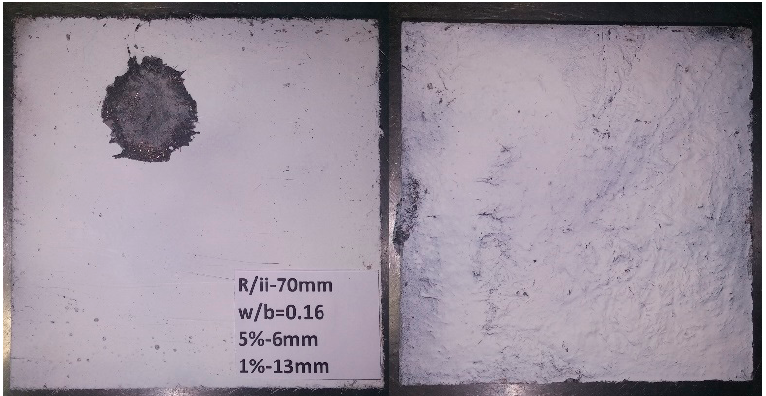
Figure 7. Failure type IIb (front face at the left and rear face at the right ). Reprinted/adapted by